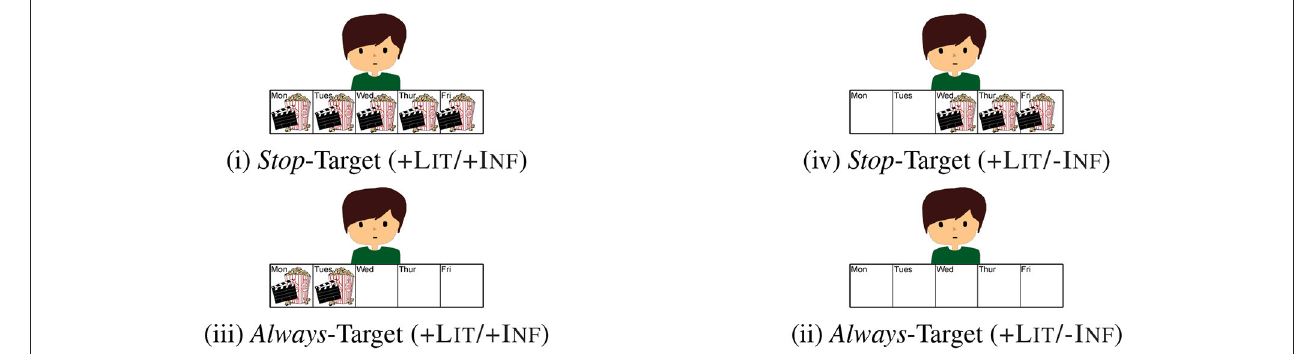
FIGURE 8 | Target pictures for Experiment II.